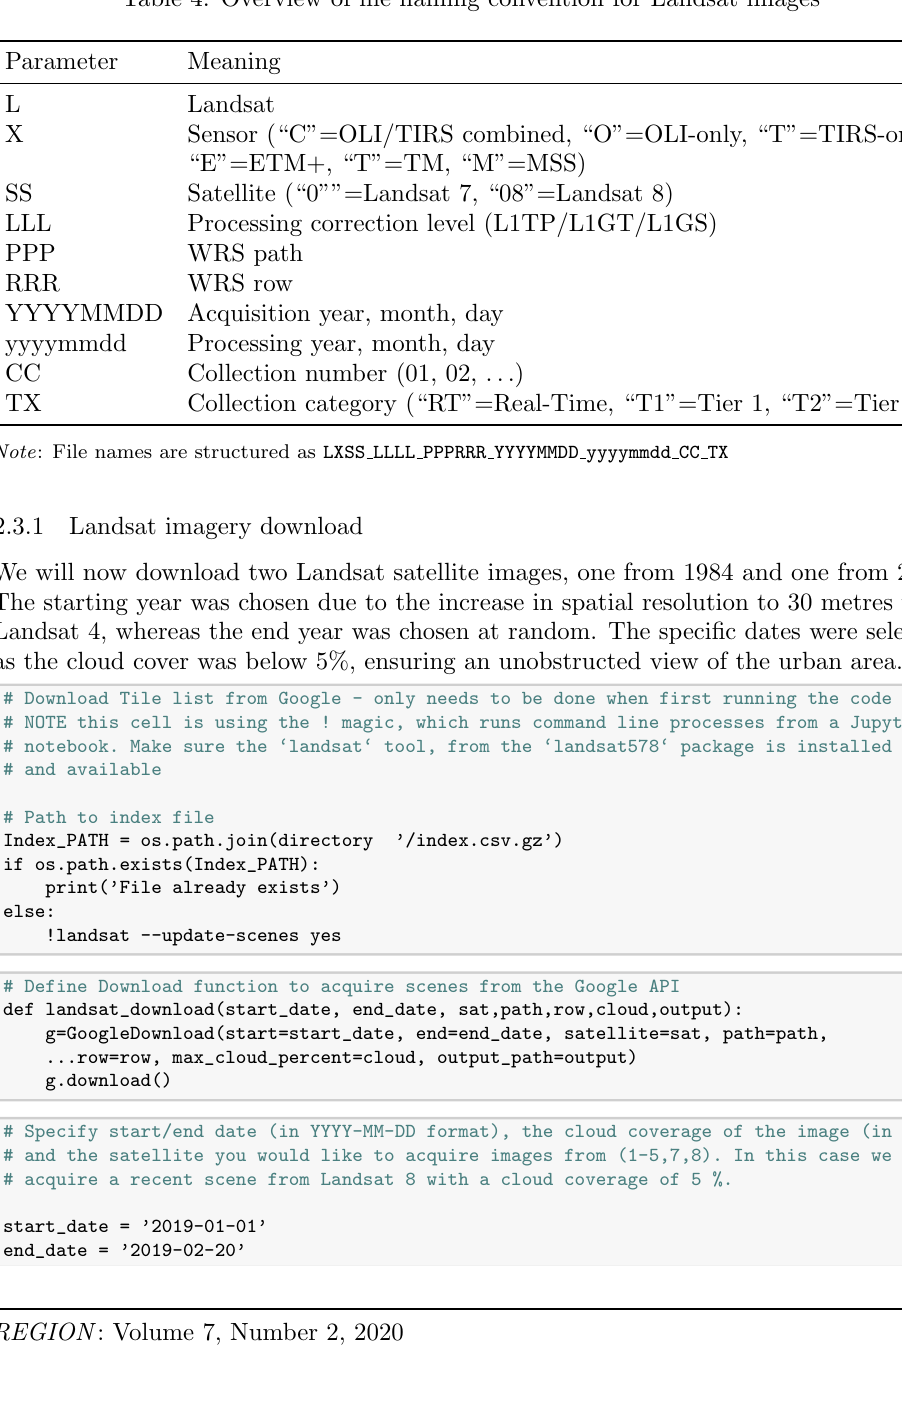
Table 4: Overview of file naming convention for Landsat